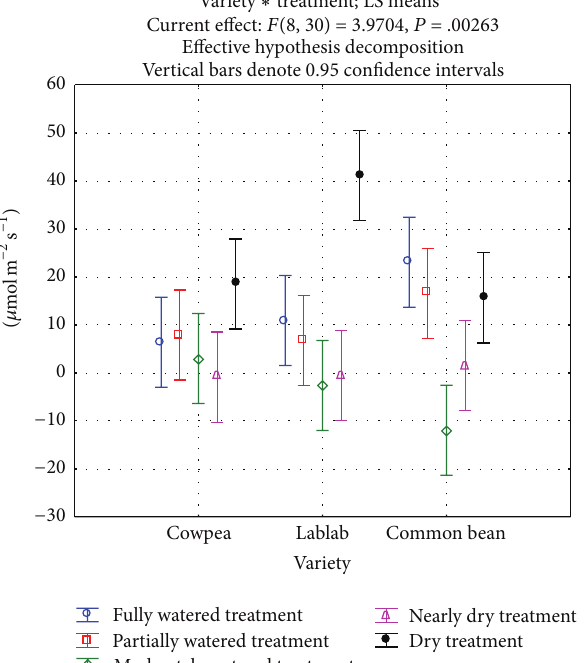
Figure 9: Photosynthesis rate on 58 DAP.